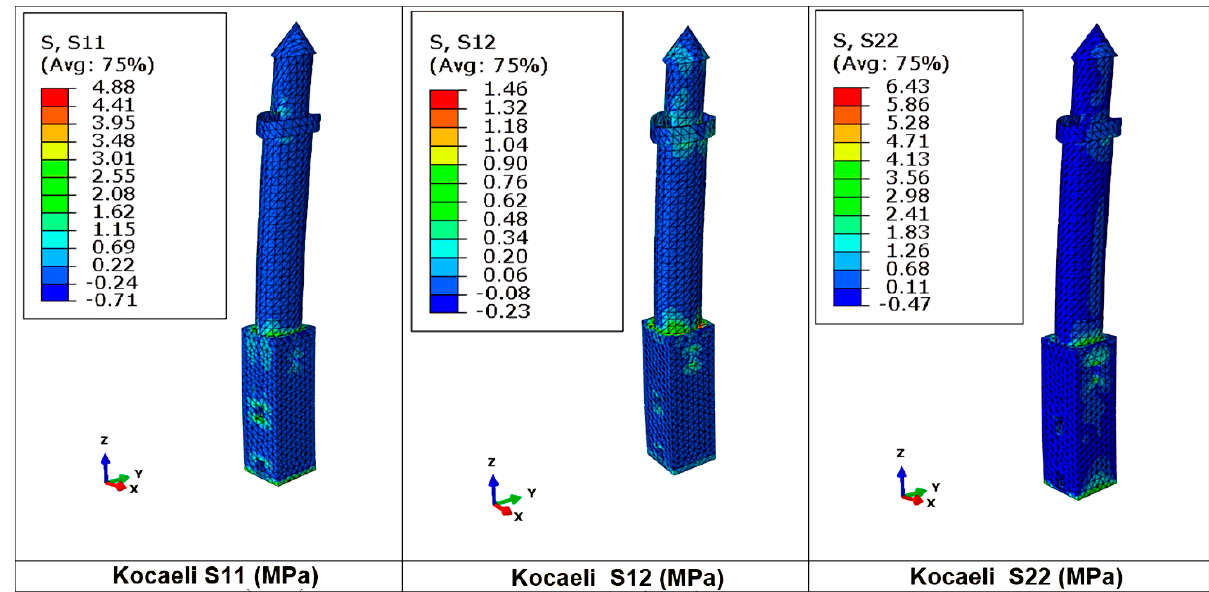
Figure 28. Stresses for Kocaeli (Central) Province.